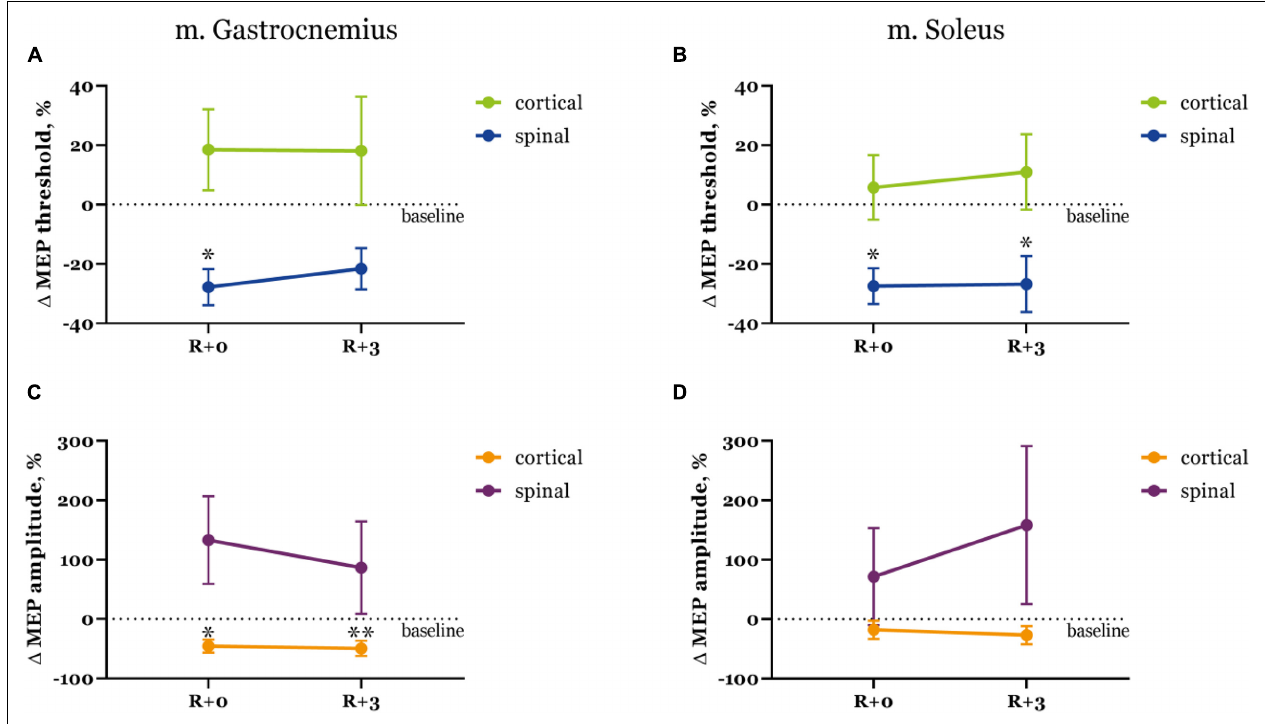
FIGURE 2 | Motor evoked potential thresholds (A,B) and MEP amplitudes (C,D) in the gastrocnemius (A,C) and soleus (B,D) muscles. Data is presented as mean ± SEM of percent changes from baseline. Baseline values are taken as zero. R + 0 – day of DI completion, R + 3 – third day after DI. ∗ p < 0.05 vs. baseline, ∗∗ p < 0.01 vs. baseline.